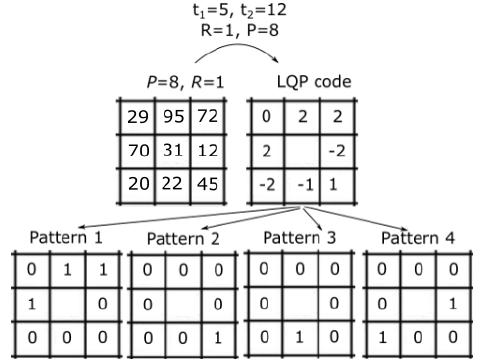
Figure 4. An illustration of computing the Local Quinary Pattern (LQP) code using P = 8 and R = 1, resulting in four binary